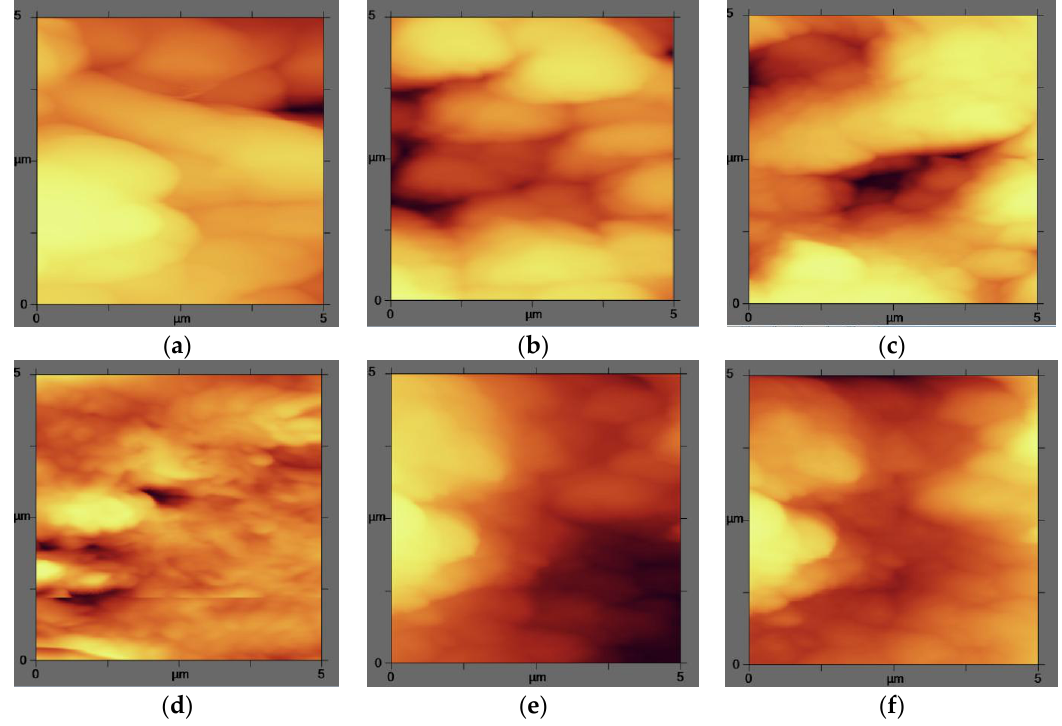
Figure 7. AFM plane images of the modified and unmodified membranes surfaces: ( a ) pure PVDF; ( b ) PVDF15; ( c ) PVDF 30; ( d ) Pure PES; ( e ) PES15; and ( f ) PES30 with a Z scale of 1 µm.